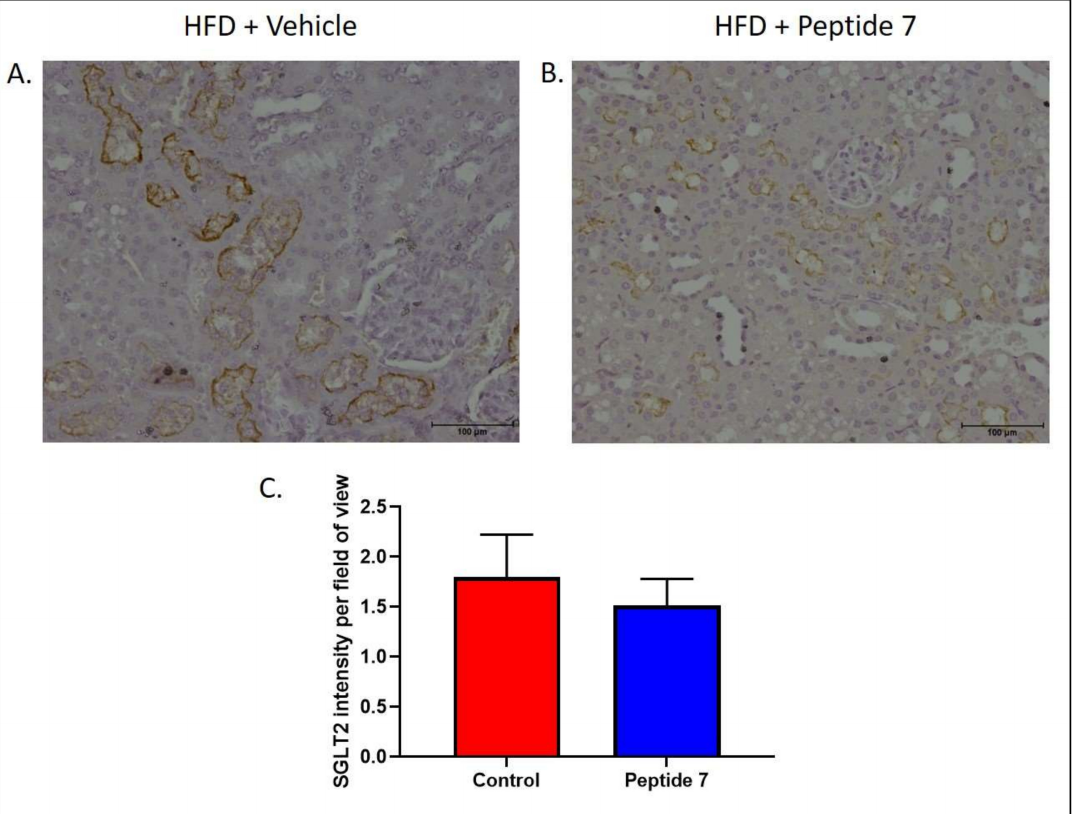
Figure 7. Peptide 7 reduced in vivo SGLT2 expression in HFD mice. SGLT2 expression in the kidney after treatment with vehicle or Peptide 7. Representative SGLT2 immunohistochemistry in mice fed HFD and treated with vehicle ( A ) or Peptide 7 ( B ). SGLT2 is depicted by brown staining. 200 × magnification. Intensity of staining of proximal tubules in kidneys rated on a scale of 0–3, 0 = no staining, 3 = highest staining; n = 4–5 mice/group. Average of five random fields of view per mouse. Mean ± SD ( C ).